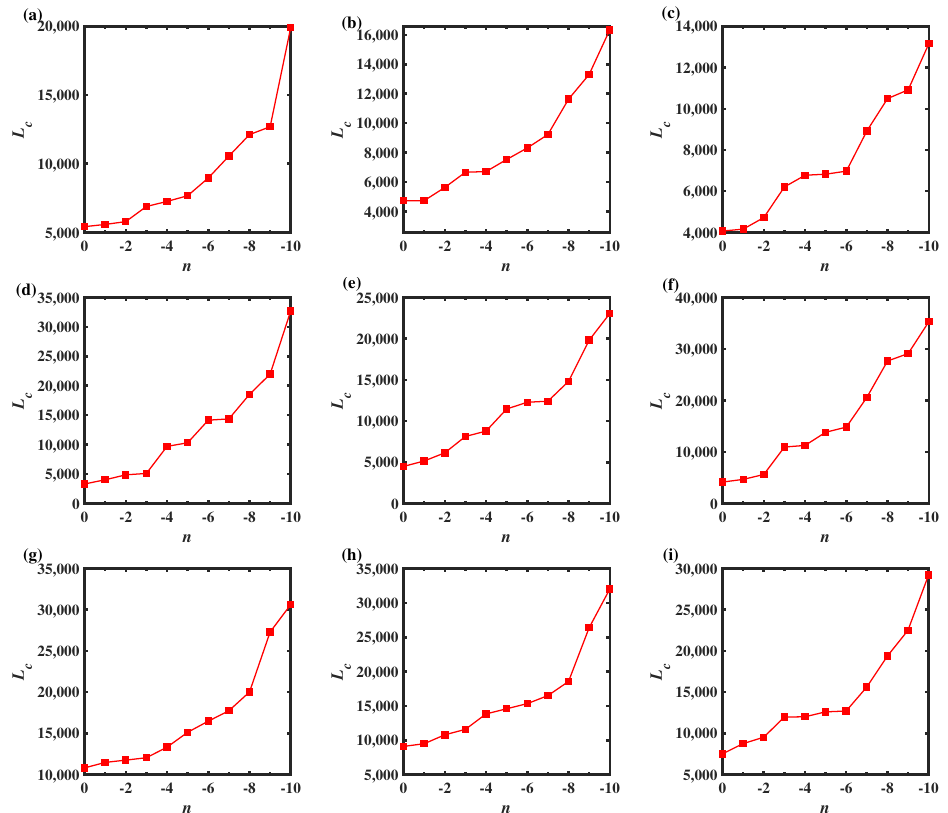
Figure 12. The change in corner position under different D values and n values. ( a ) D = 1.1, ( b ) D = 1.2, ( c ) D = 1.3, ( d ) D = 1.4, ( e ) D = 1.5, ( f ) D = 1.6, ( g ) D = 1.7, ( h ) D = 1.8, ( i ) D =